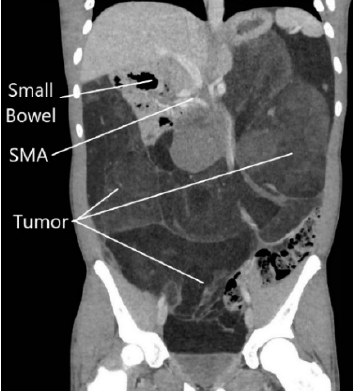
Figure 1. Abdominal computed tomography scan showing massive retroperitoneal liposarcoma, with displacement of the small intestine to the right upper quadrant.